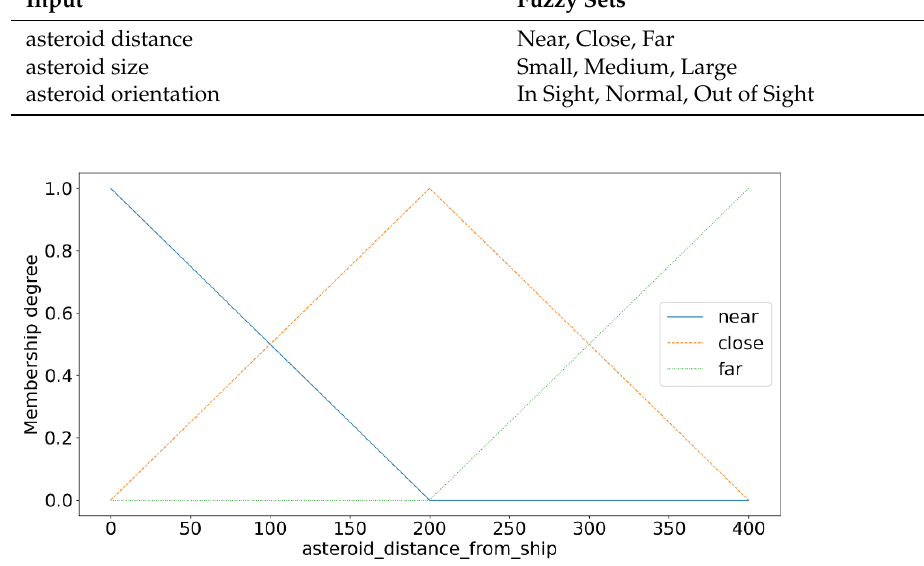
Figure 6. Asteroid distance fuzzy set.